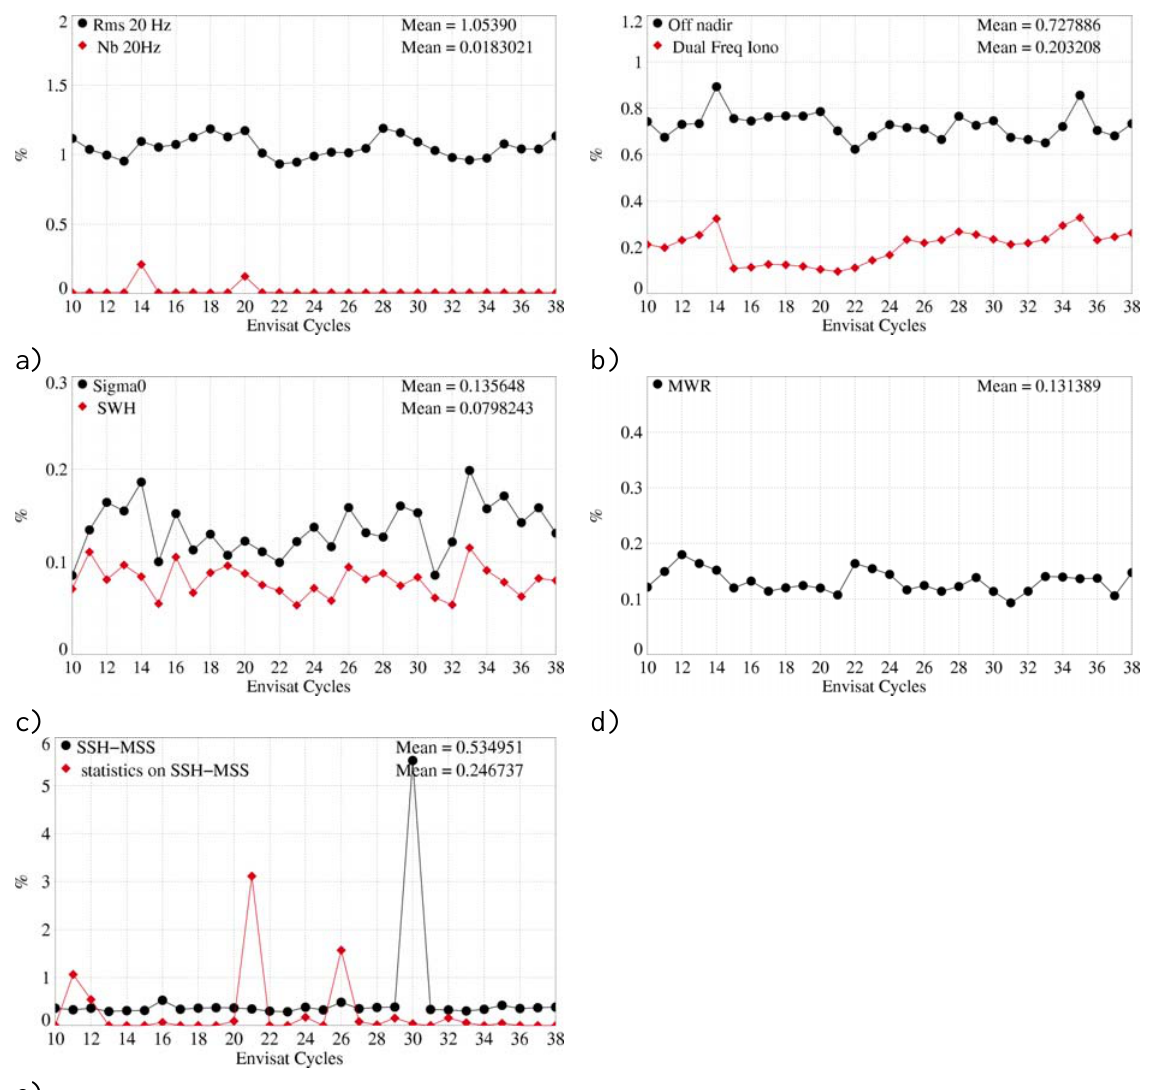
Figure 4. Cycle per cycle percentages of edited measurements by the main Envisat altimeter and radiometer